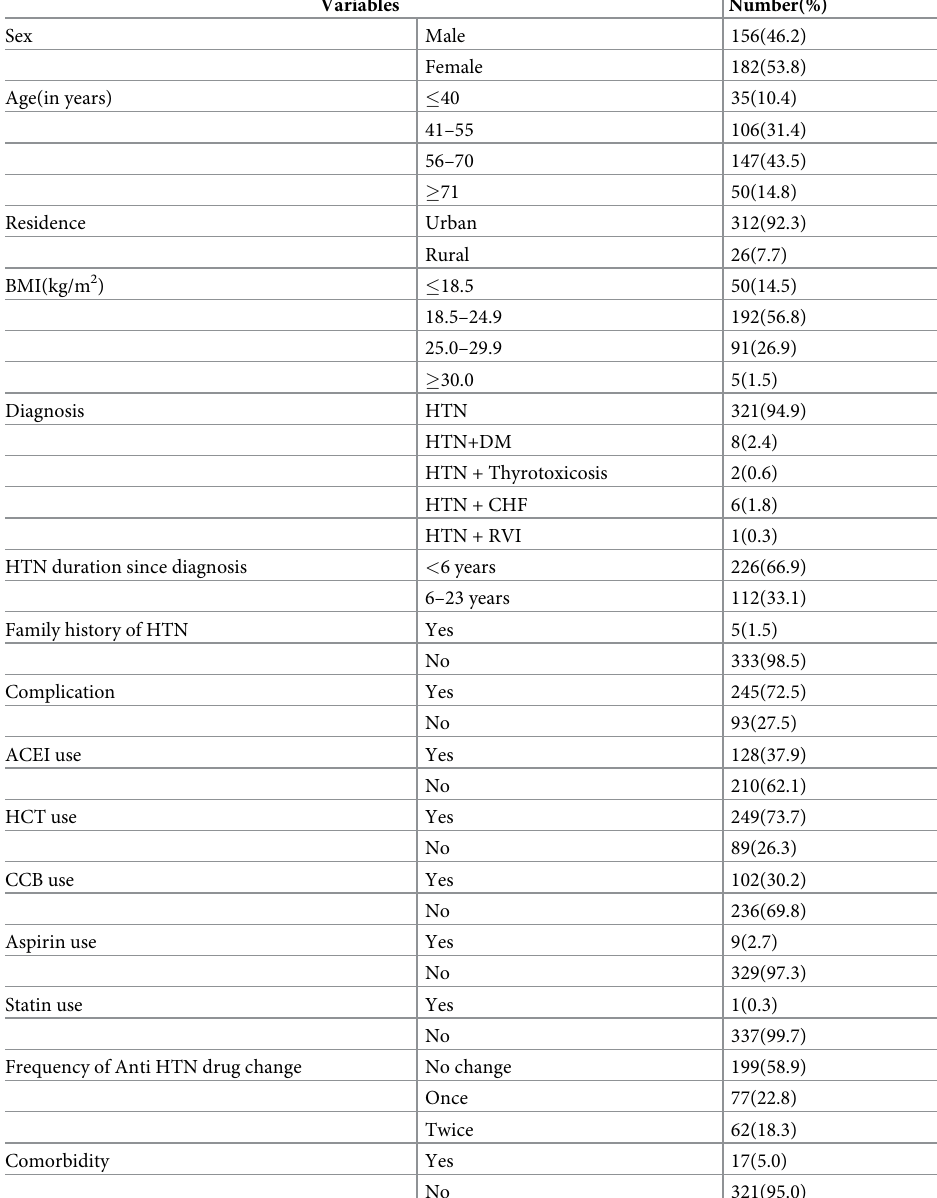
Table 1. Socio-demographic and clinical characteristics of adult ambulatory hypertensive patients in Mekelle Hospital,